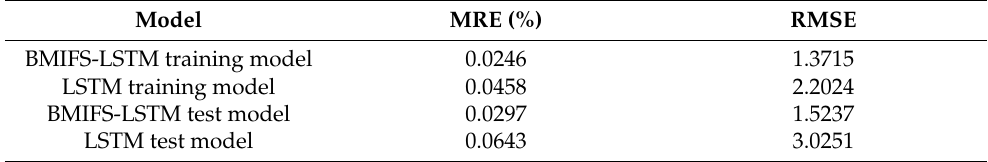
Table 3. Comparison table of simulation results.